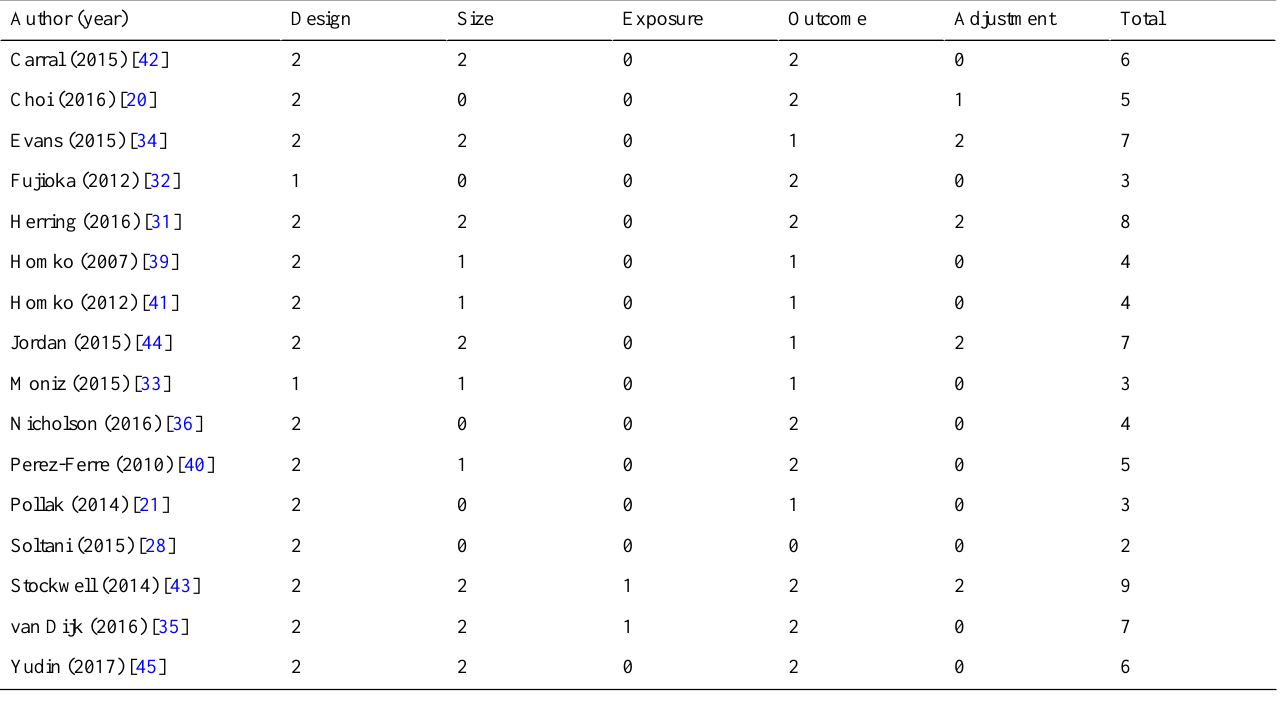
Table 4. Quality scores included studies evaluated on effectiveness in